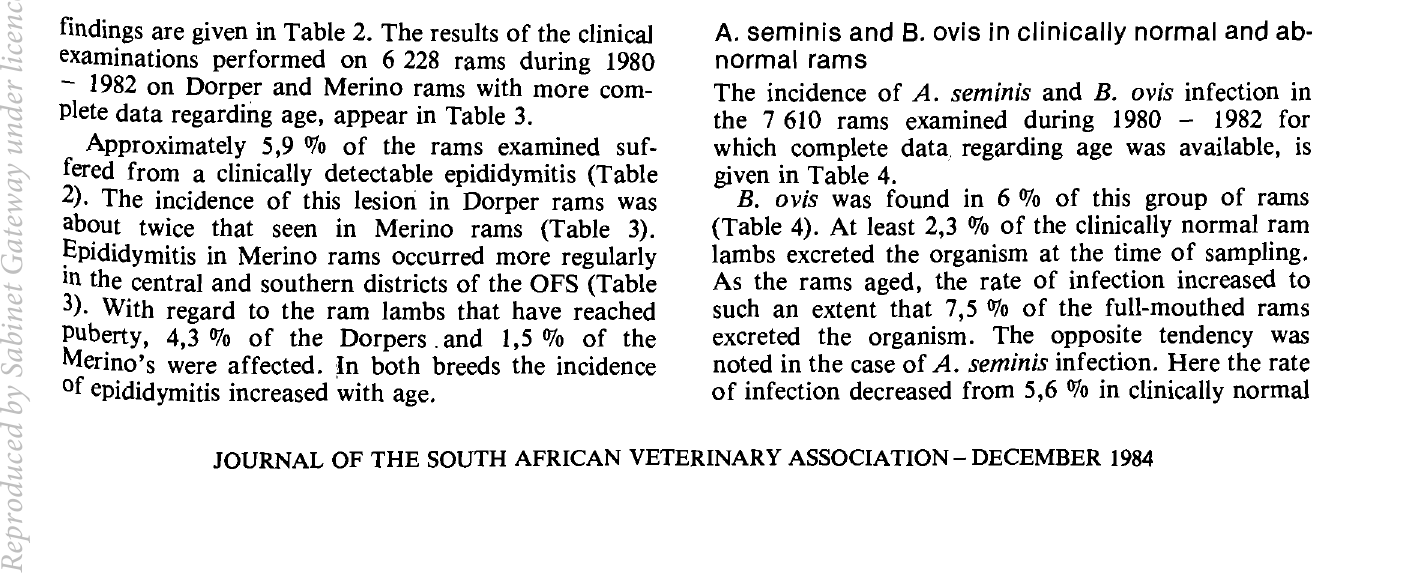
Table 4: THE INCIDENCE OF A. SEMINISc AND B. OVIS INFECTION IN CLINICALLY NORMAL RAMS AND IN RAMS WITH CLINICAL EPIDIDYMITIS Age